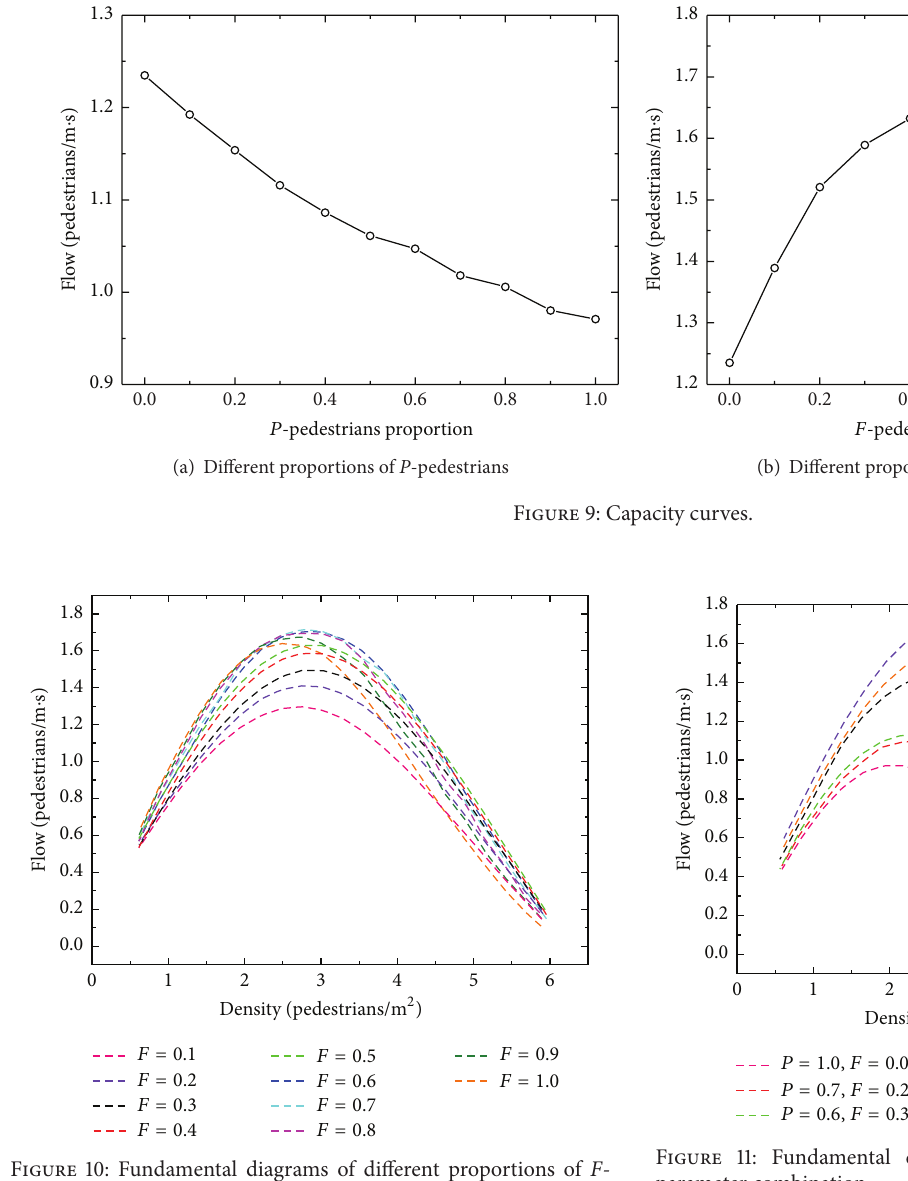
Figure 10: Fundamental diagrams of different proportions of F - pedestrians.